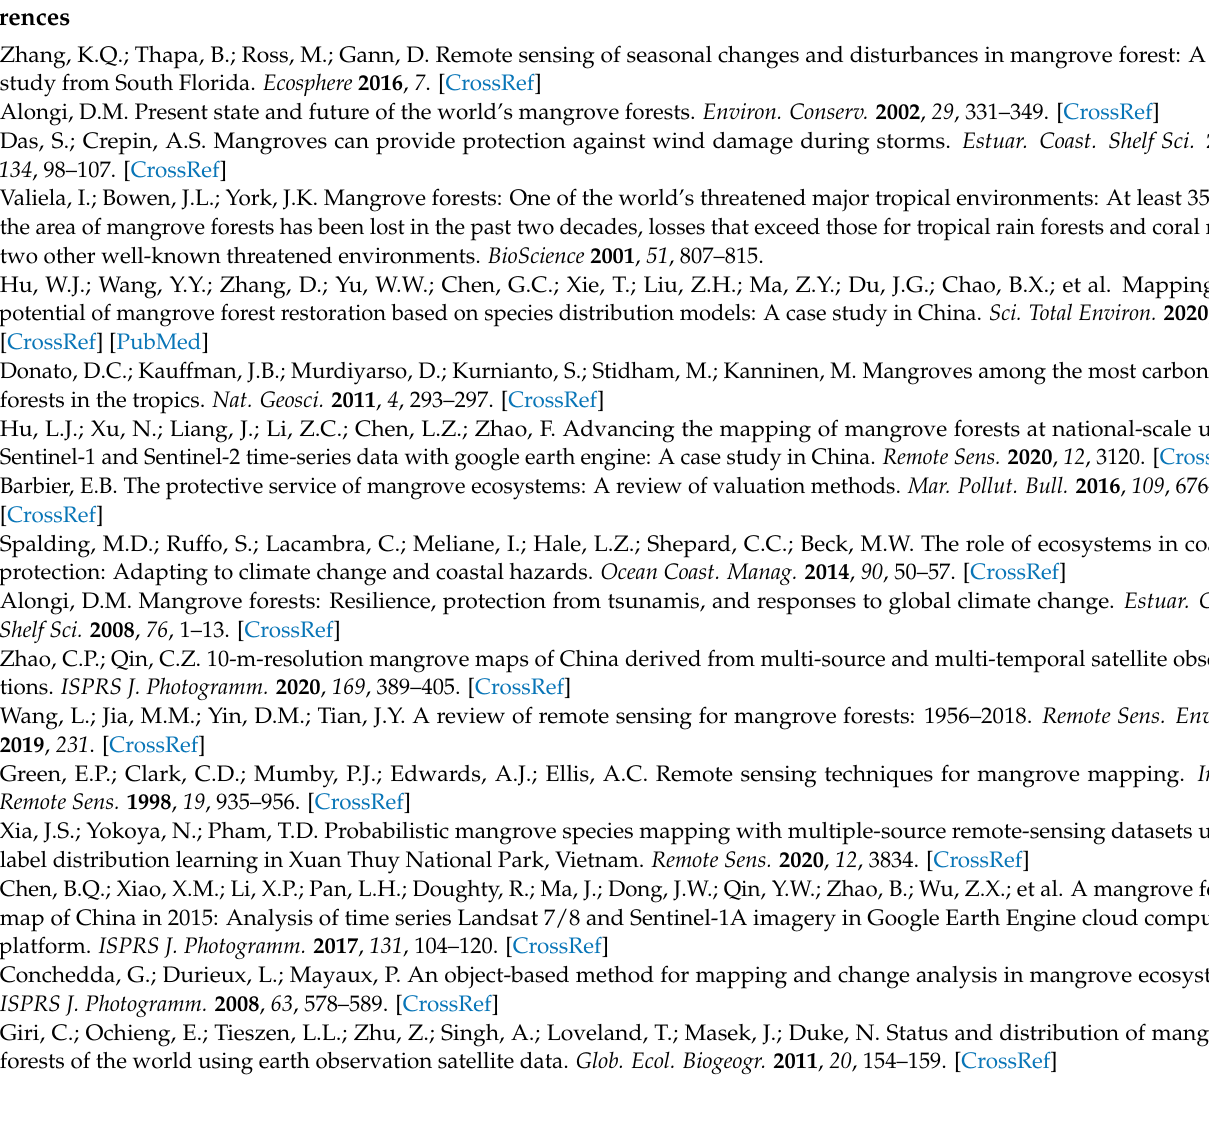
Figure A1. The variation in the silhouette coefficient with the number of clusters.